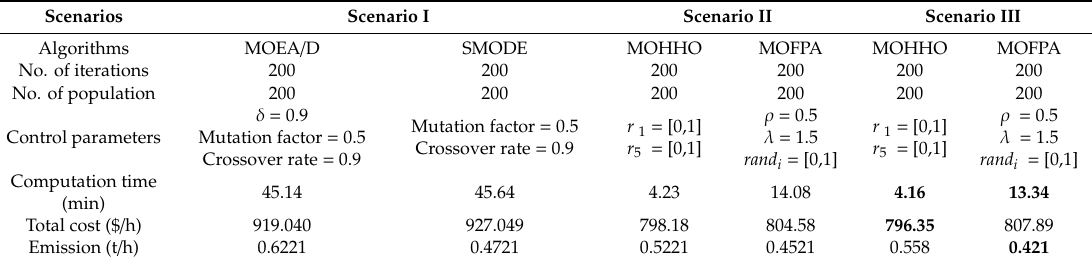
Table 9. Comparative analysis between optimization techniques for three